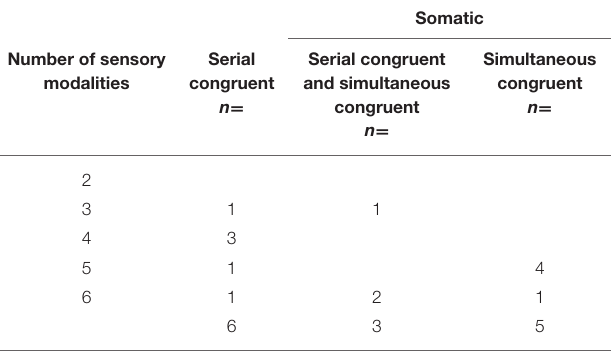
TABLE 3B | Interrelatedness of the sensory modalities in the patients having somatic hallucinations ( n = 14).